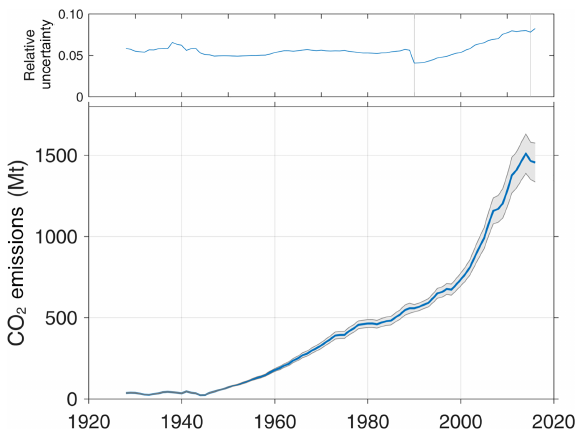
Figure 2. Global process emissions from cement production, with 95% confidence interval. A step change in uncertainty occurs in 1990, reflecting a significant change in data availability.